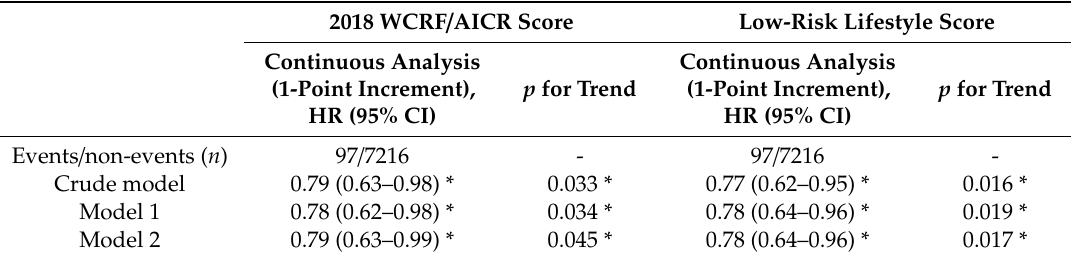
Table 2. HRs and 95% CIs between the 2018 WCRF / AICR and the low-risk lifestyle scores and colorectal cancer risk at baseline in the PREDIMED study ( n =